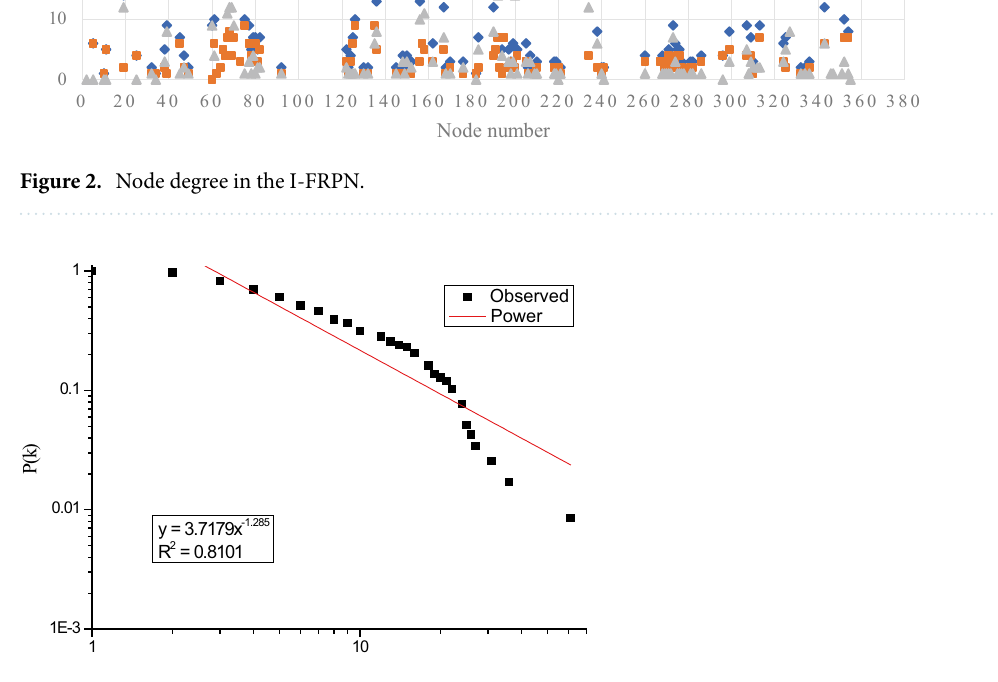
Figure 3. Cumulative degree distribution of the